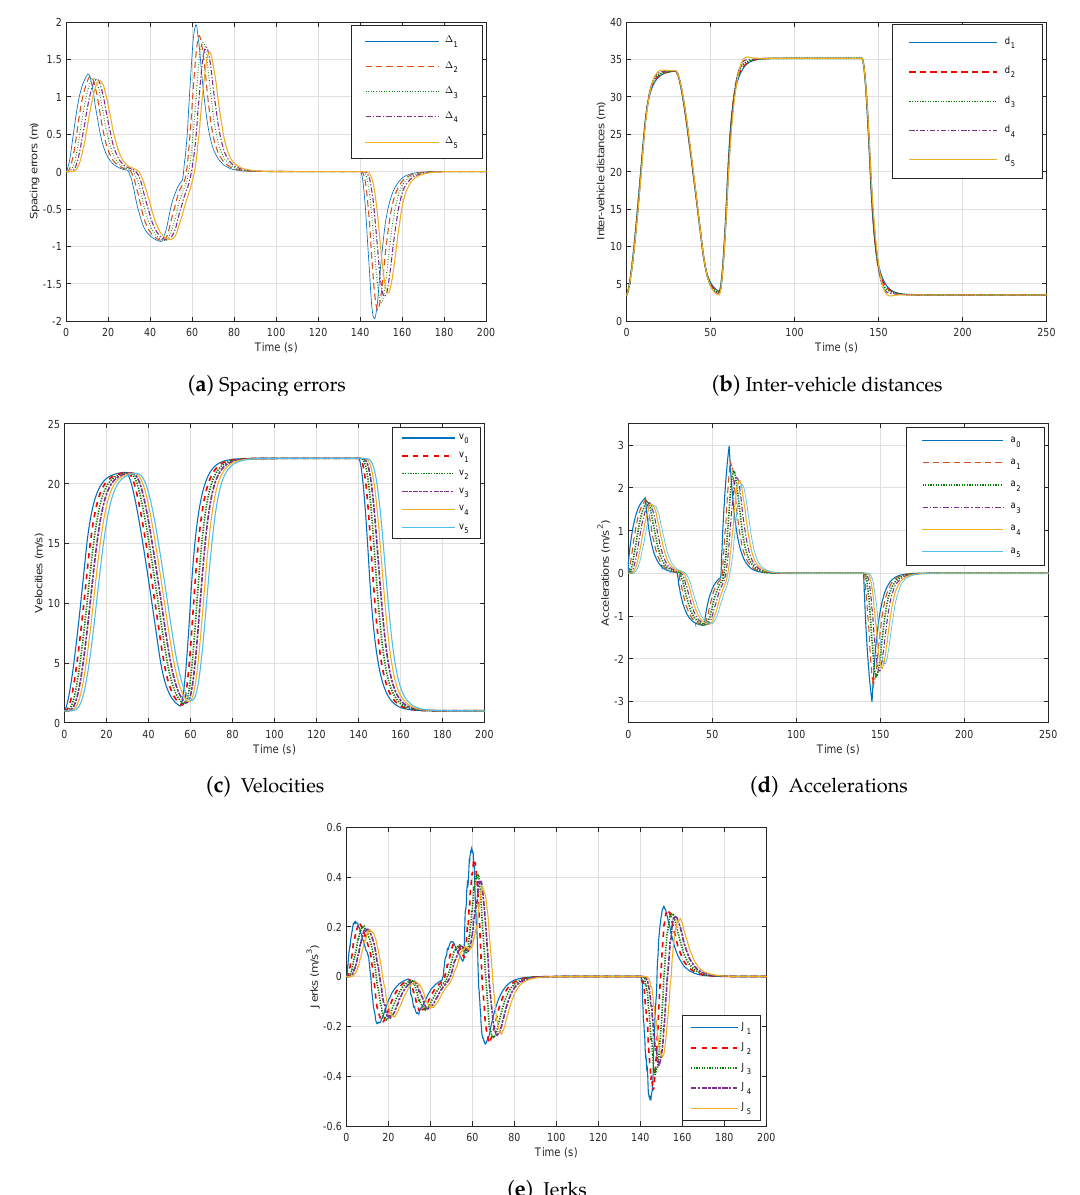
Figure 9. Six-vehicle platoon system under controller (48) through communication network with h d =